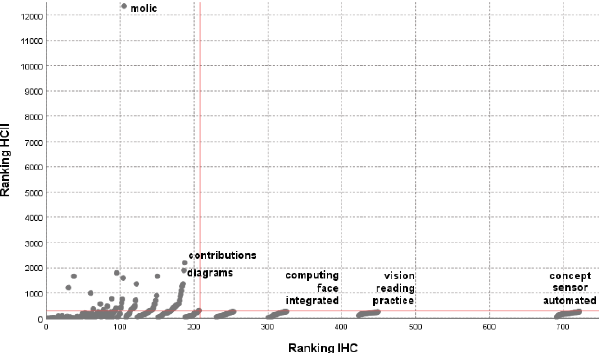
Figure 15. Scatterplot considering 50% of the Fri% of the ranking of each